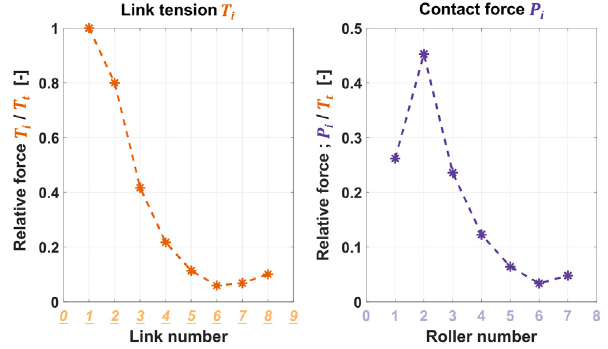
Fig. 17. Variation of P i and T i ( c t ,1 = a 1